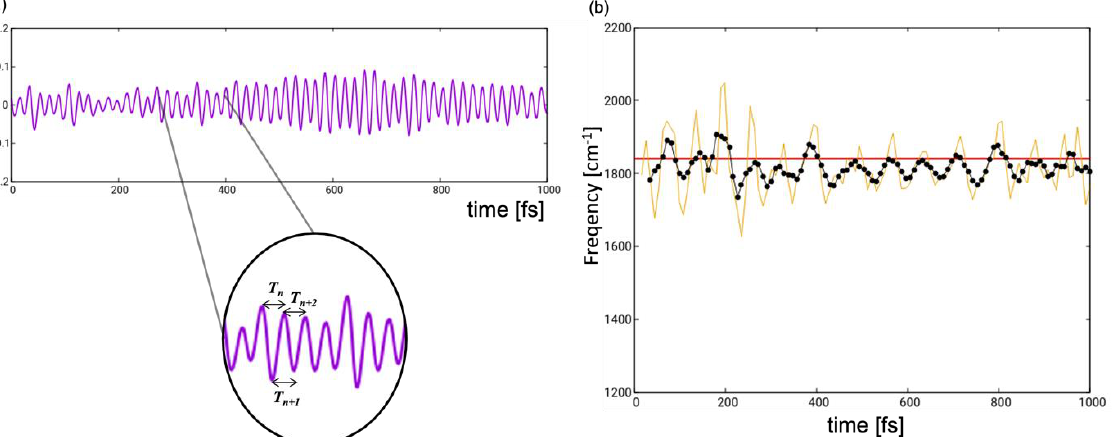
Figure 8. ( a ) Oscillating function representing the antisymmetric stretching which originates from subtracting the values of the two carbonyl groups at each time step along a representative trajectory. ( b ) Time evolution (yellow line) of the frequency of the antisymmetric stretching mode computed as the inverse of the time interval between two consecutive maxima or minima (see inset of ( a )); black dotted line indicates the time-evolution of frequency averaged over five periods; red horizontal line represents the frequency of the antisymmetric stretching calculated at the GS equilibrium structure at DFT/CAM-B3LYP level.